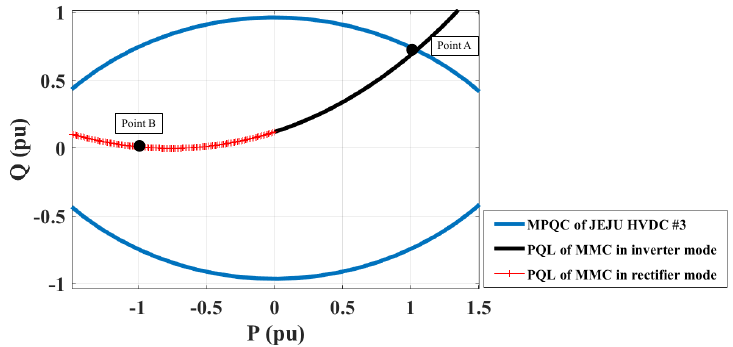
Figure 16. The PQ loading curve required from MMC-HVDC in Jeju Island considering bidirectional power flow in MILM case under lowered short circuit capacity due to the high penetration of wind power.